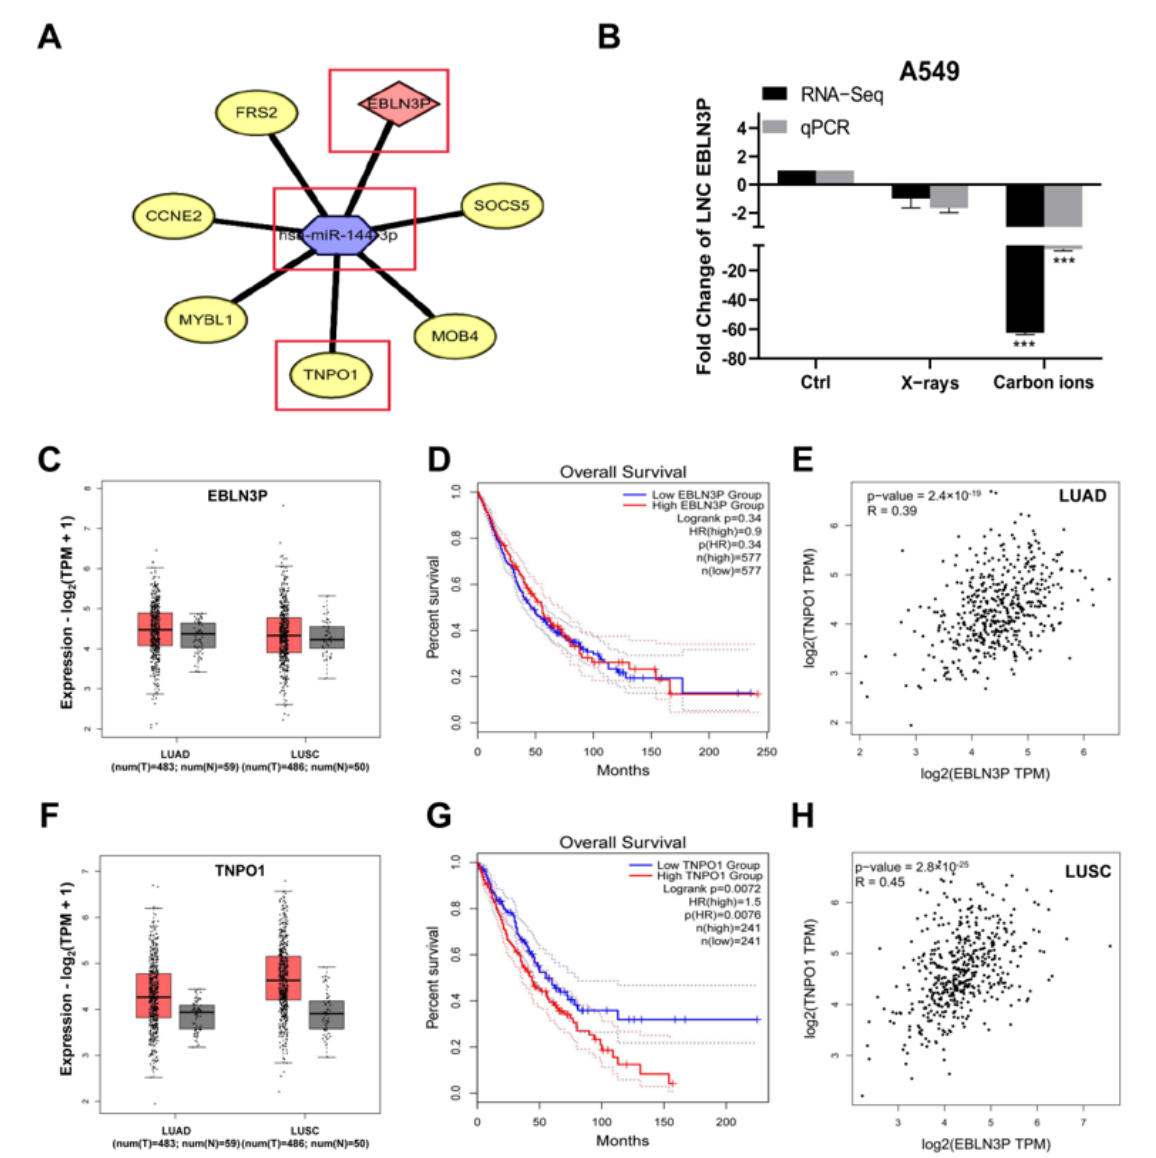
Figure 1. LNC EBLN3P expression is down − regulated by X − ray or carbon ion irradiation in A549 cells. ( A ) The potential ceRNA network is predicted according to the highest down − regulated lncRNA, EBLN3P, which is also named as LNC EBLN3P. ( B ) The relative expression of LNC EBLN3P in A549 cells after X − ray (2 Gy) or carbon ion (2 Gy) irradiation was analyzed by RNA − seq and qRT − PCR. ( C , F ) The relative expression of LNC EBLN3P and TNPO1 in lung cancer tissues (T) and normal tissues (N). ( D , G ) The overall survival (OS) of lung cancer patients with high expression (red line) and low expression (blue line) of LNC EBLN3P or TNPO1. ( E , H ) The co − expression analysis of EBLN3P and TNPO1 in lung adenocarcinoma (LUAD) and lung squamous carcinoma (LUSC). *** p < 0.001.